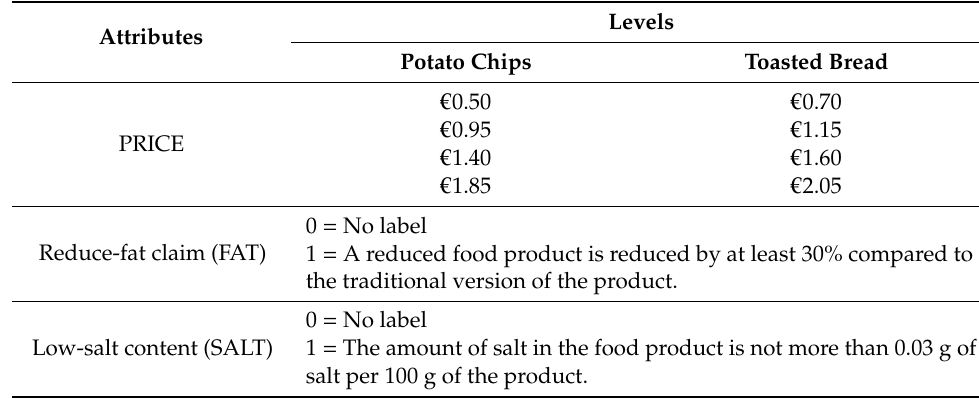
Table 1. Attributes and levels used in the choice experiment (CE) design for potato chips and toasted